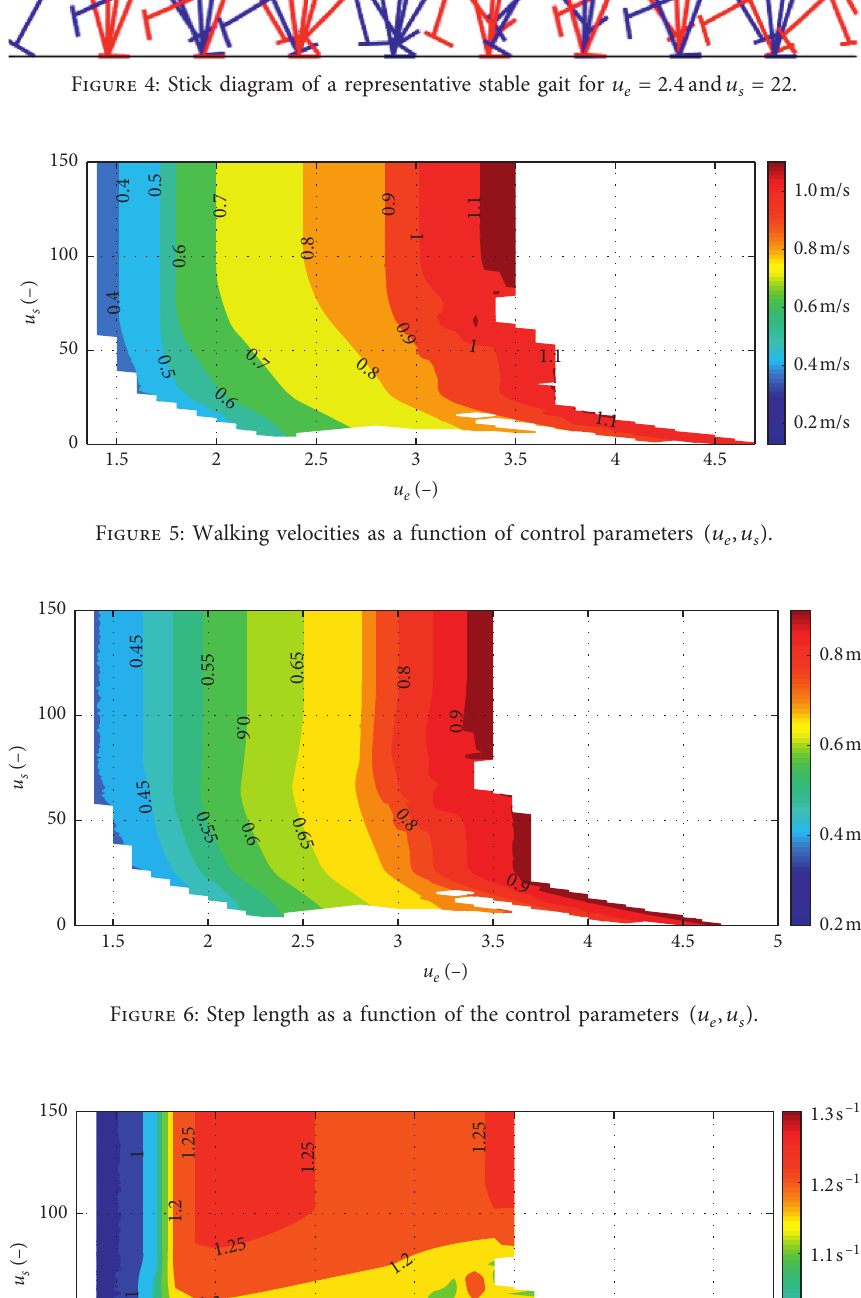
Figure 4: Stick diagram of a representative stable gait for u